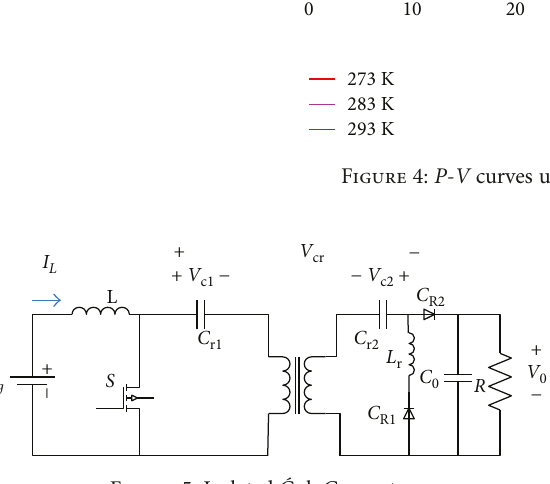
Figure 5: Isolated Ć uk